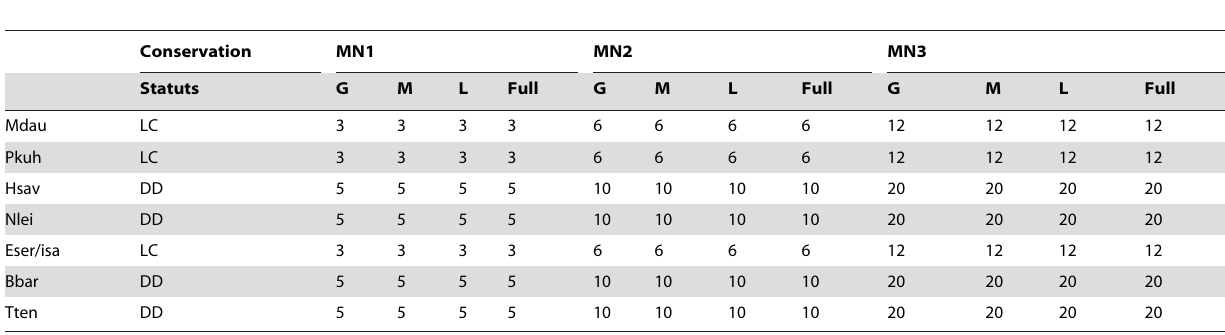
Table 1. Minimum number of locations targeted in each monitoring network (MN1, MN2 and MN3) for each species suitability class (G – Likely Gain; M – Likely Maintain; L – Likely Loss) and for areas predicted as currently suitable in the full model (Full).